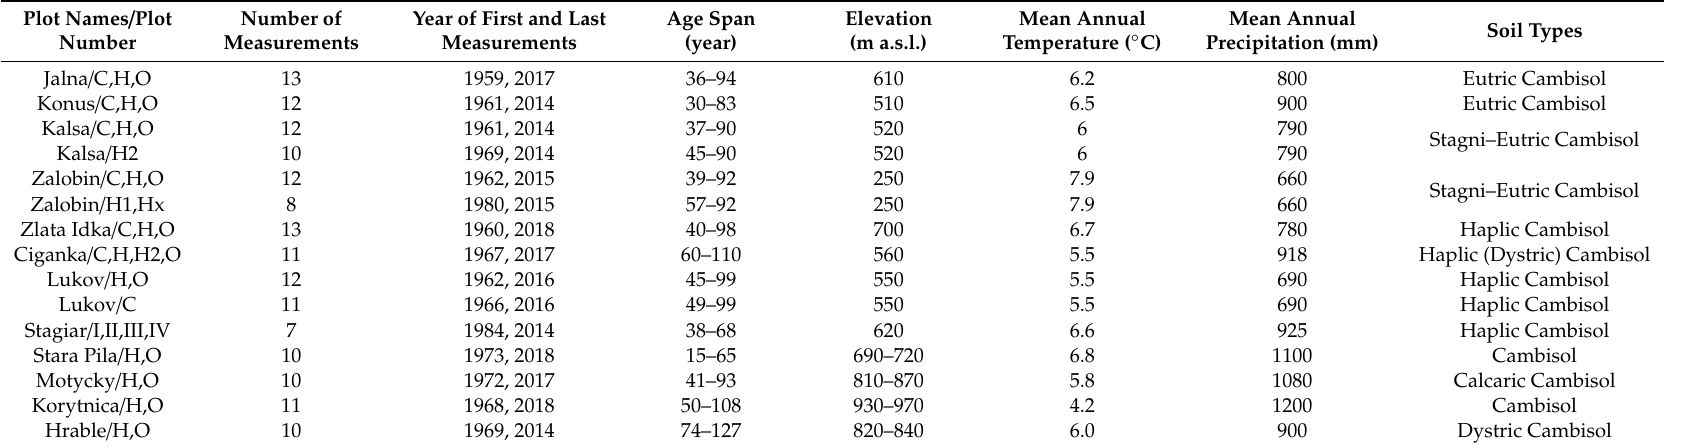
Table 1. Site characteristics of the long-term research sample plots with dominating European beech ( Fagus sylvatica L.) included in data analysis [24]. Plot Names /